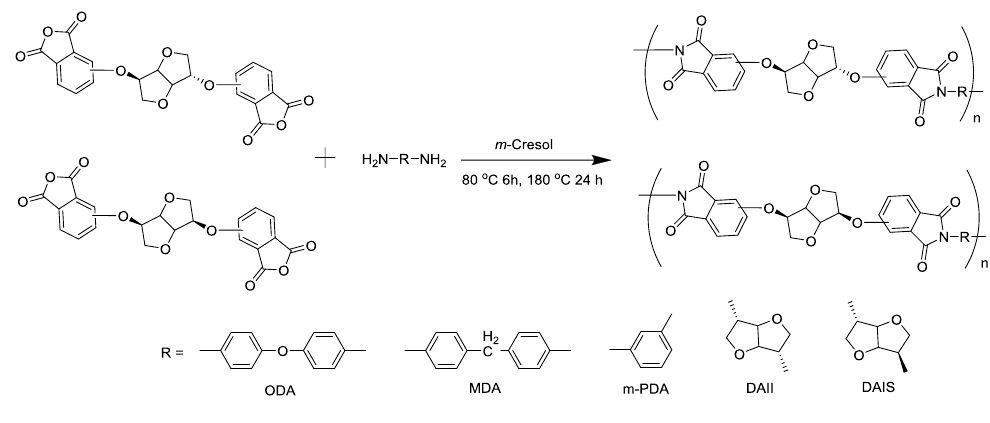
Table 1. Bio-based contents, inherent viscosity, and solubility of isohexide-derived PEIs.